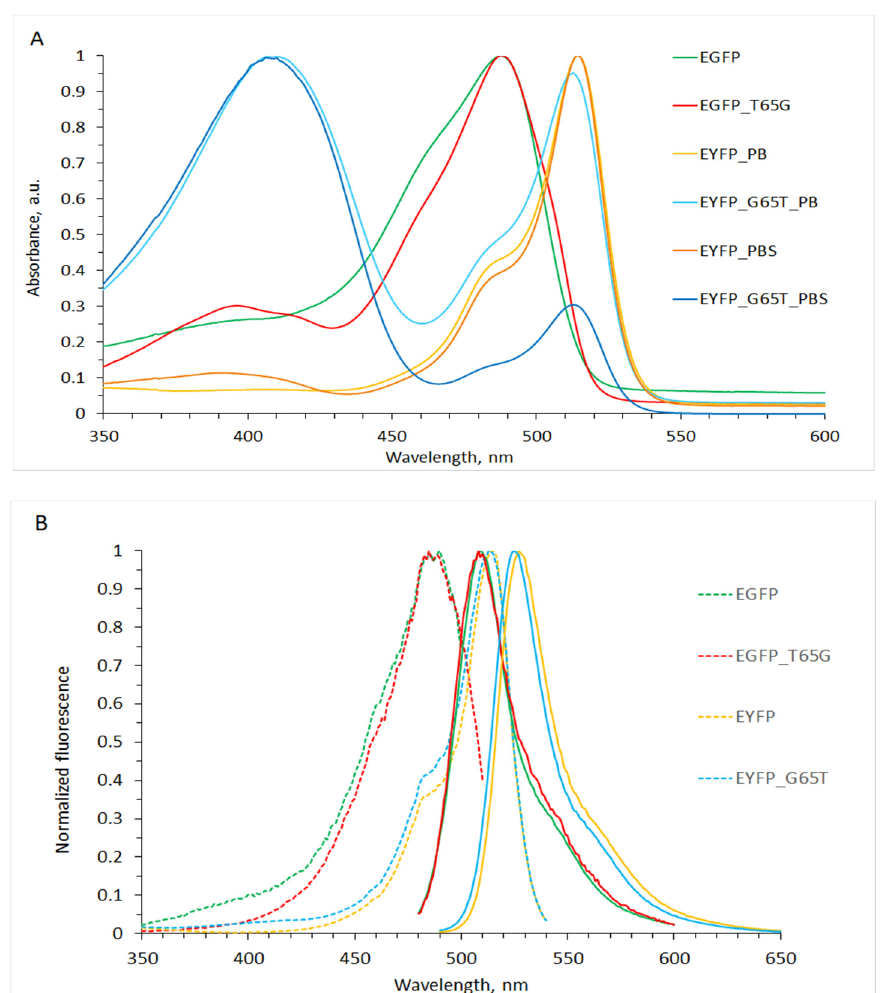
Figure 1. ( A ) Absorption and ( B ) fluorescence spectra of enhanced green fluorescent protein (EGFP), enhanced yellow fluorescent protein (EYFP), and mutants. In the fluorescence graph, dashed lines show fluorescence excitation, solid lines show fluorescence emission. ‘PB’ denotes phosphate buffer and ‘PBS’ denotes phosphate buffered saline containing sodium chloride (see text).